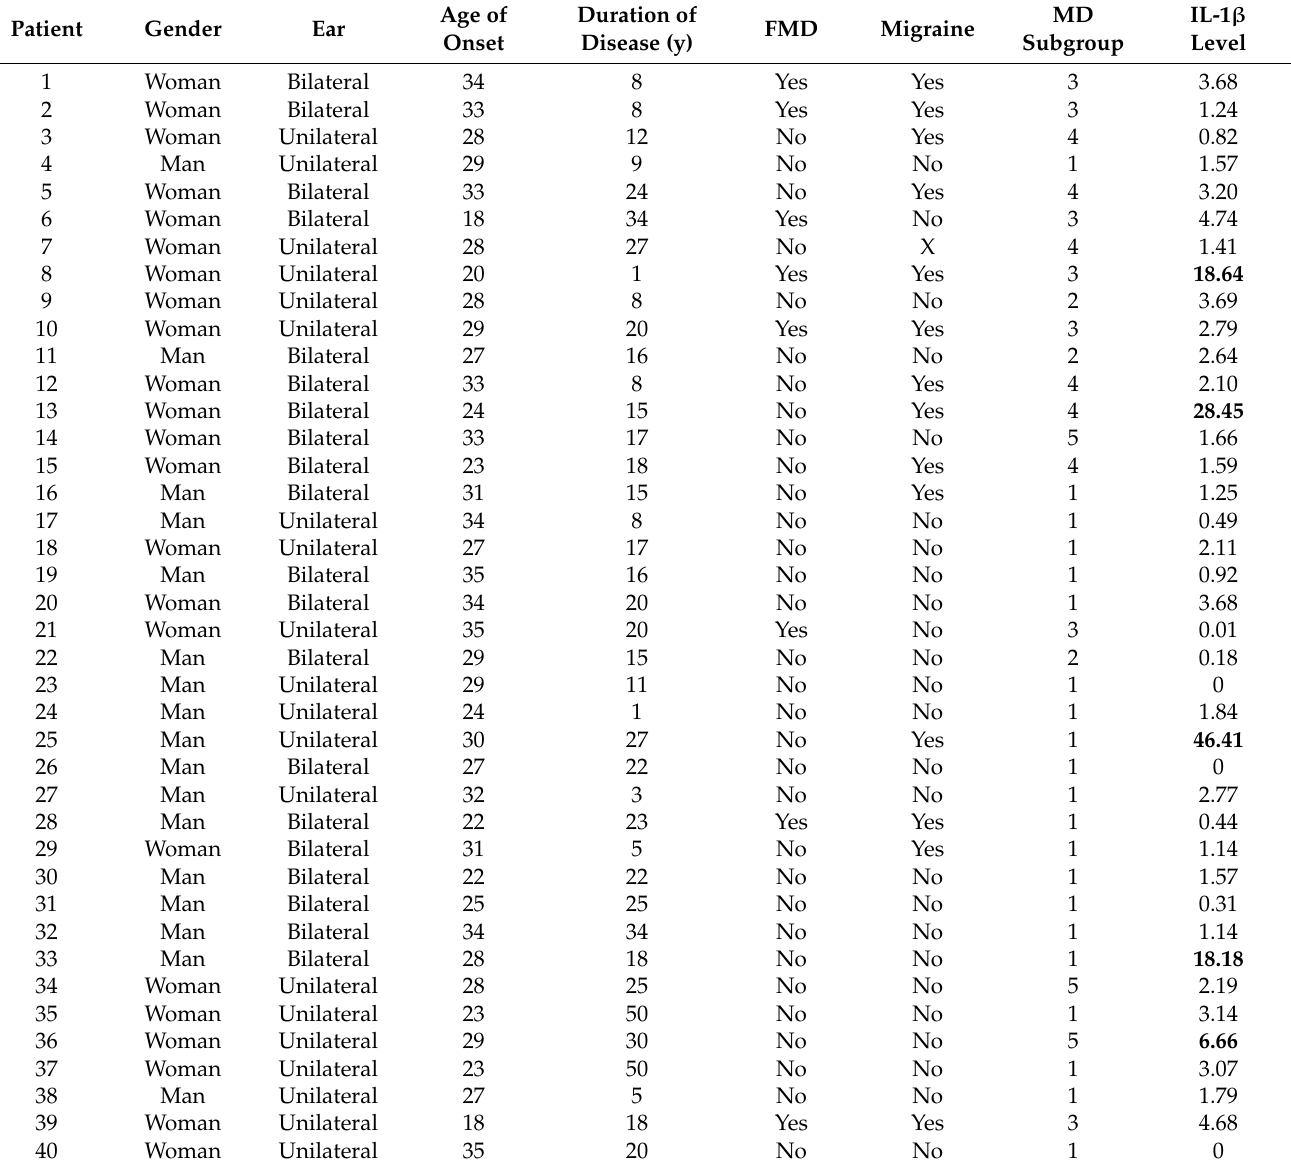
Table 2. Clinical features and basal levels of IL-1 β cytokine in patients with EOMD ( n = 44). Elevated levels of IL-1 β are highlighted in bold